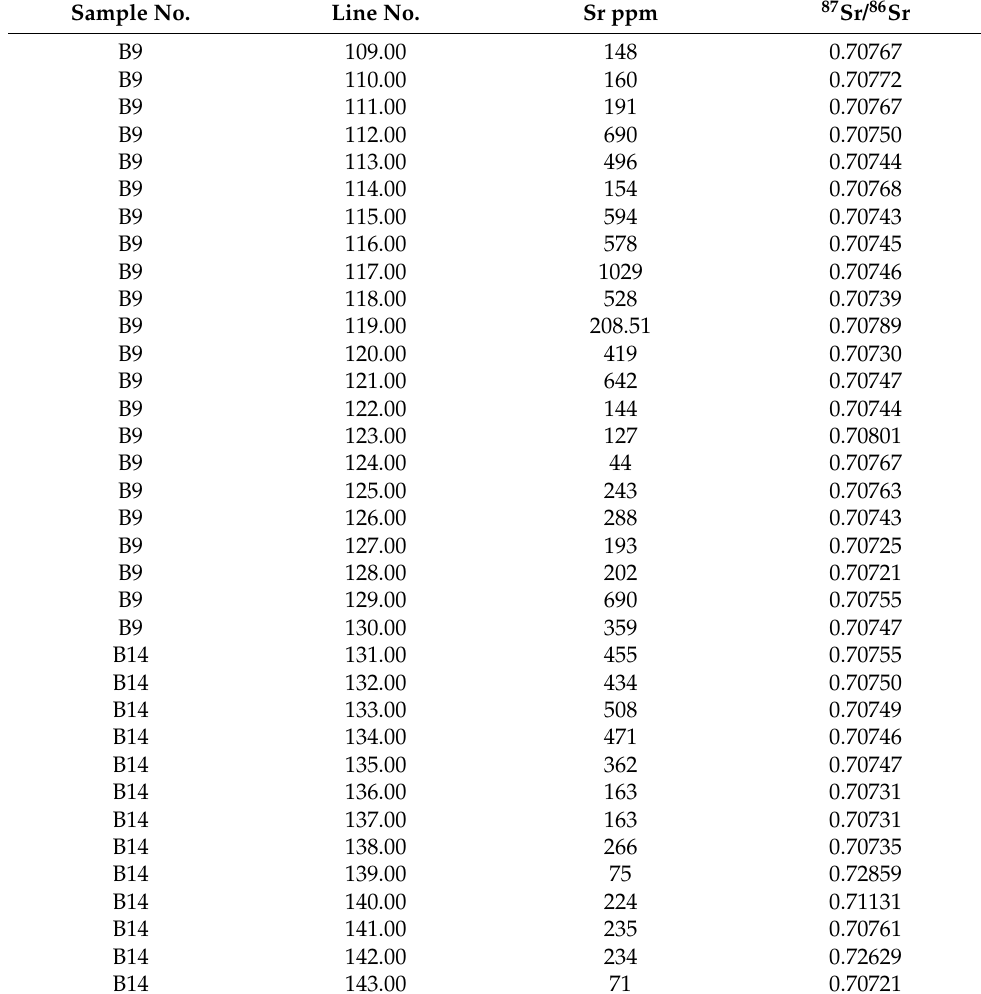
Table 2. Strontium concentration values and 87 Sr/ 86 Sr ratios by laser spots analyses using ICP-MS (B9, B14, n =